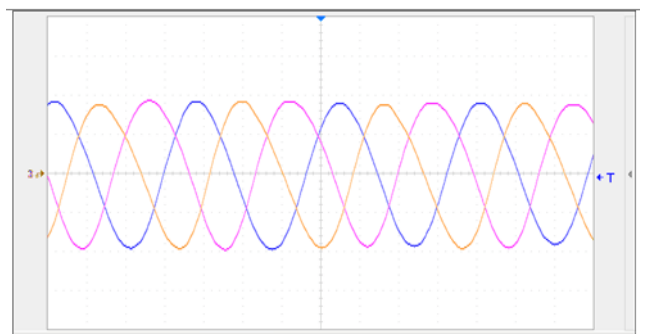
Figure 23. Measured loading currents (4 A/div).